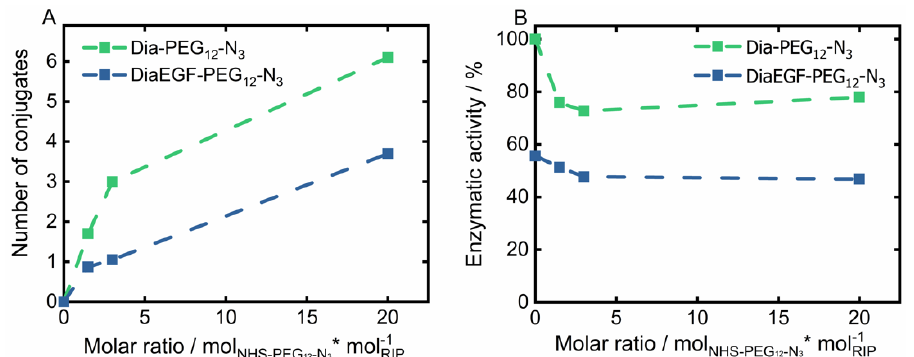
Figure 2. ( A ) Total amount of conjugated NHS-PEG 12 -N 3 linker on Dianthin (Dia) and DianthinEGF (DiaEGF) and ( B ) the corresponding enzymatic activity in dependence of the initially used molar ratio of linker to the respective ribosome-inactivating protein (RIP; Dia or DiaEGF). Activity results are shown relative to the activity of unconjugated Dia, which was set to 100%.